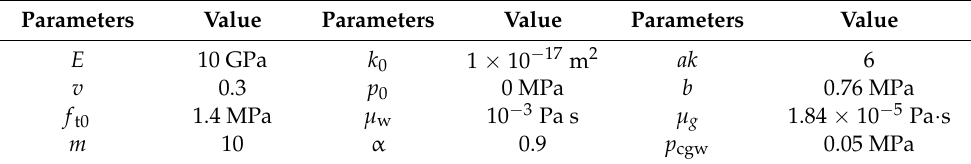
Table 1. Physical and mechanics parameters of numerical calculation model.